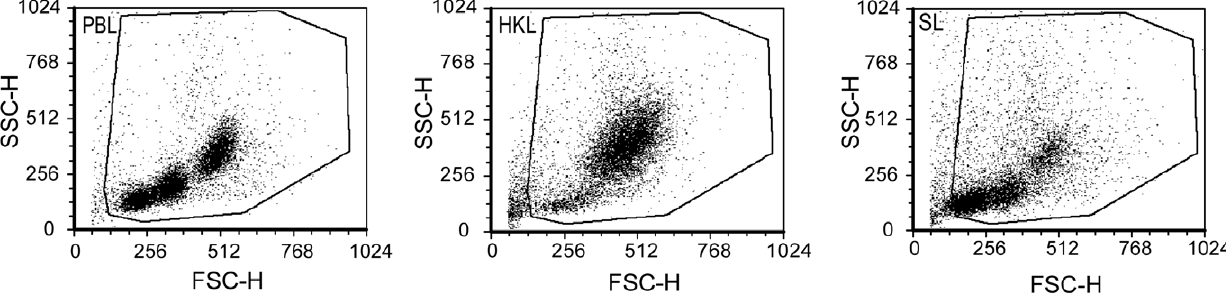
Figure 3. Flow cytometry analyses of leucocytes isolated from peripheral blood, head kidney and spleen. Representative size/ granularity (FSC/SSC) dot plots, show different sub populations among PBL, HKL and SL. The regions used in the analyses, representing the live cells, are delimited in each panel.